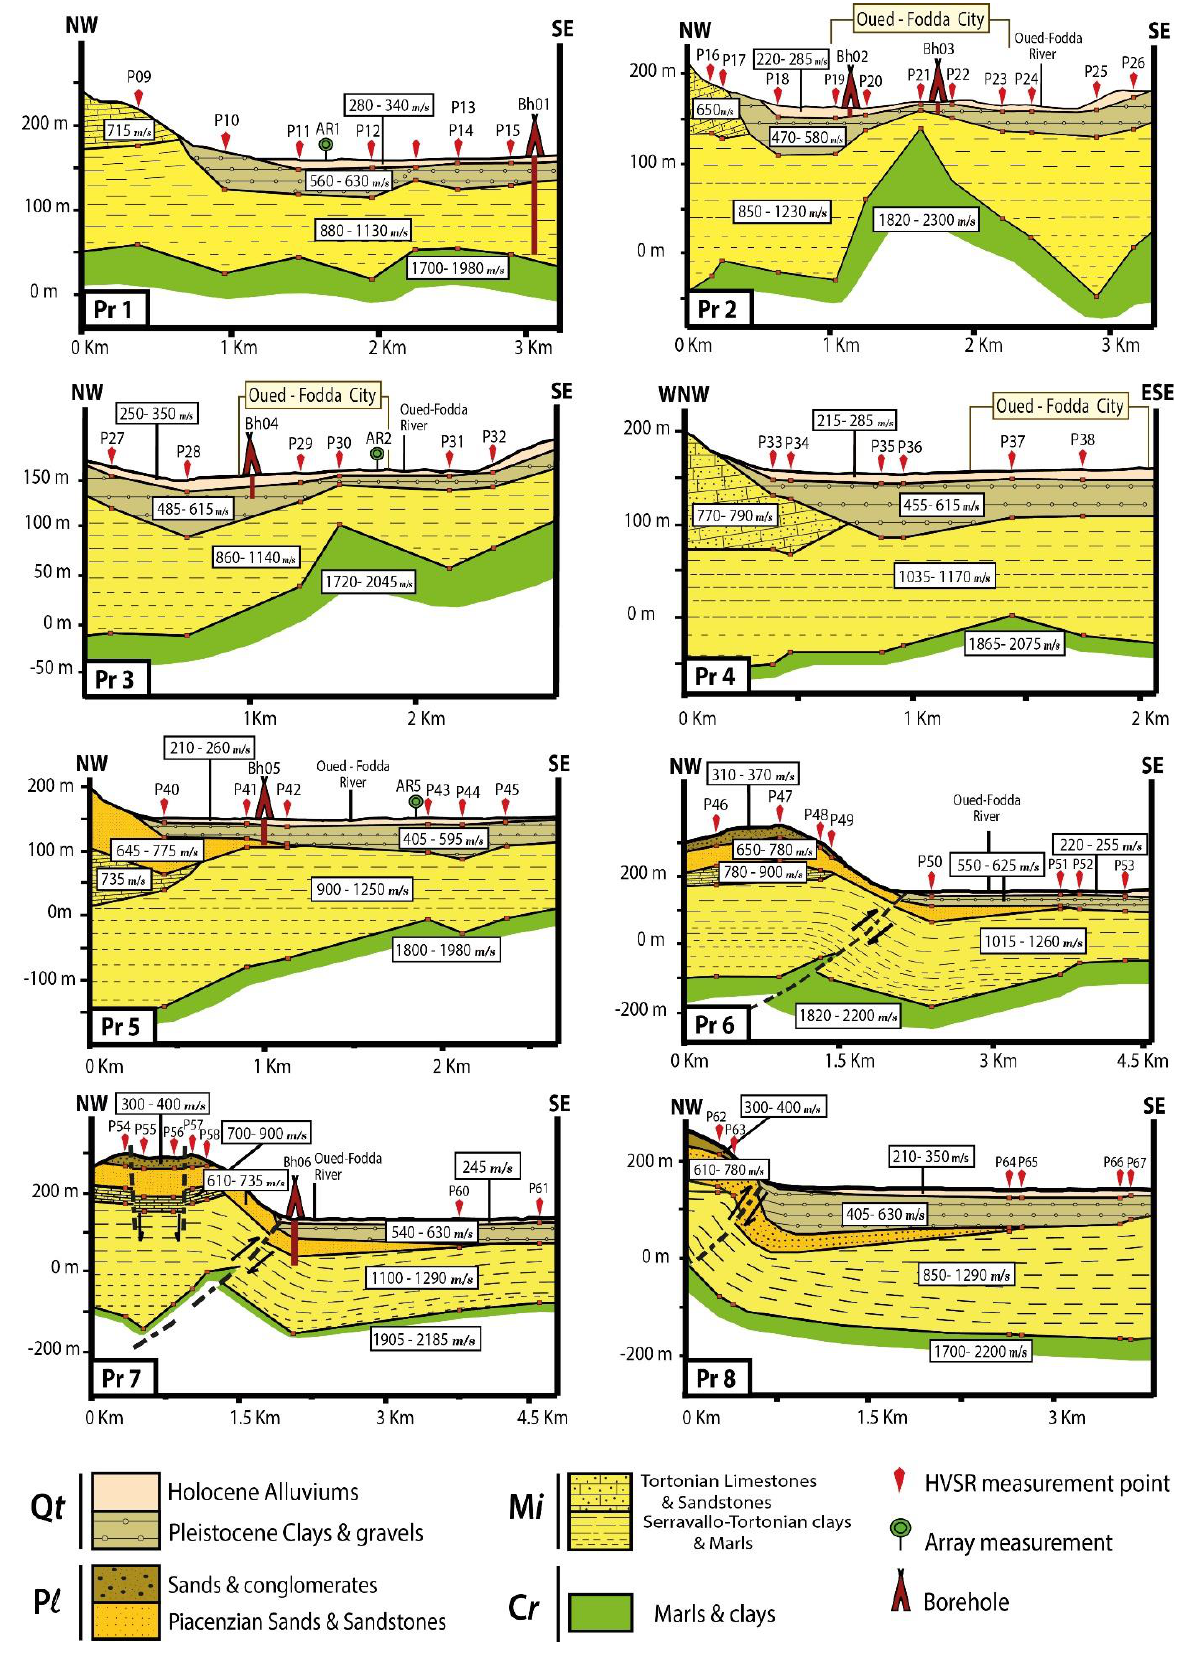
Figure 13. 2D Shear-wave velocity profiles for Zone 1. Qt: Quaternary. Pl: Pliocene. Mi: Miocene. Cr: Cretaceous.